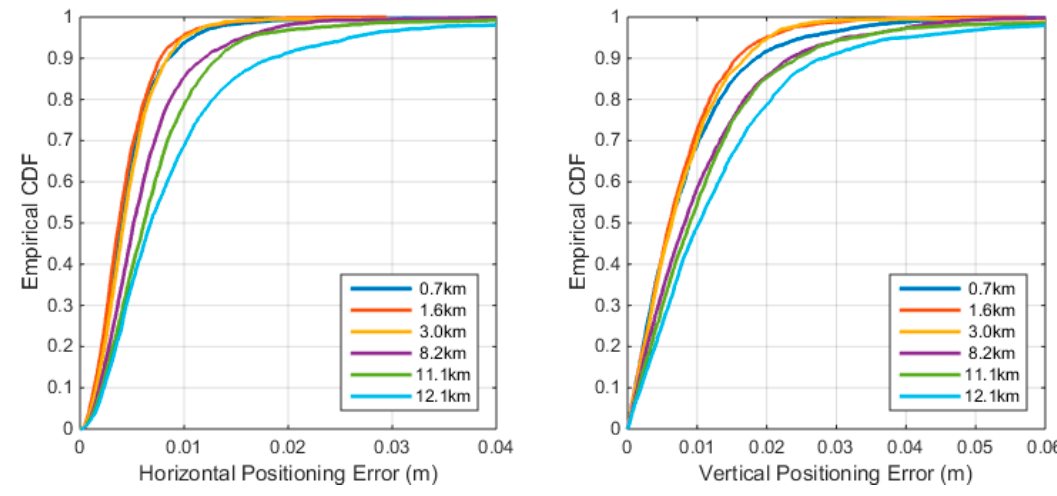
Figure 13. The empirical cumulative distribution function (CDF) of positioning error with difference distance to the VRS.